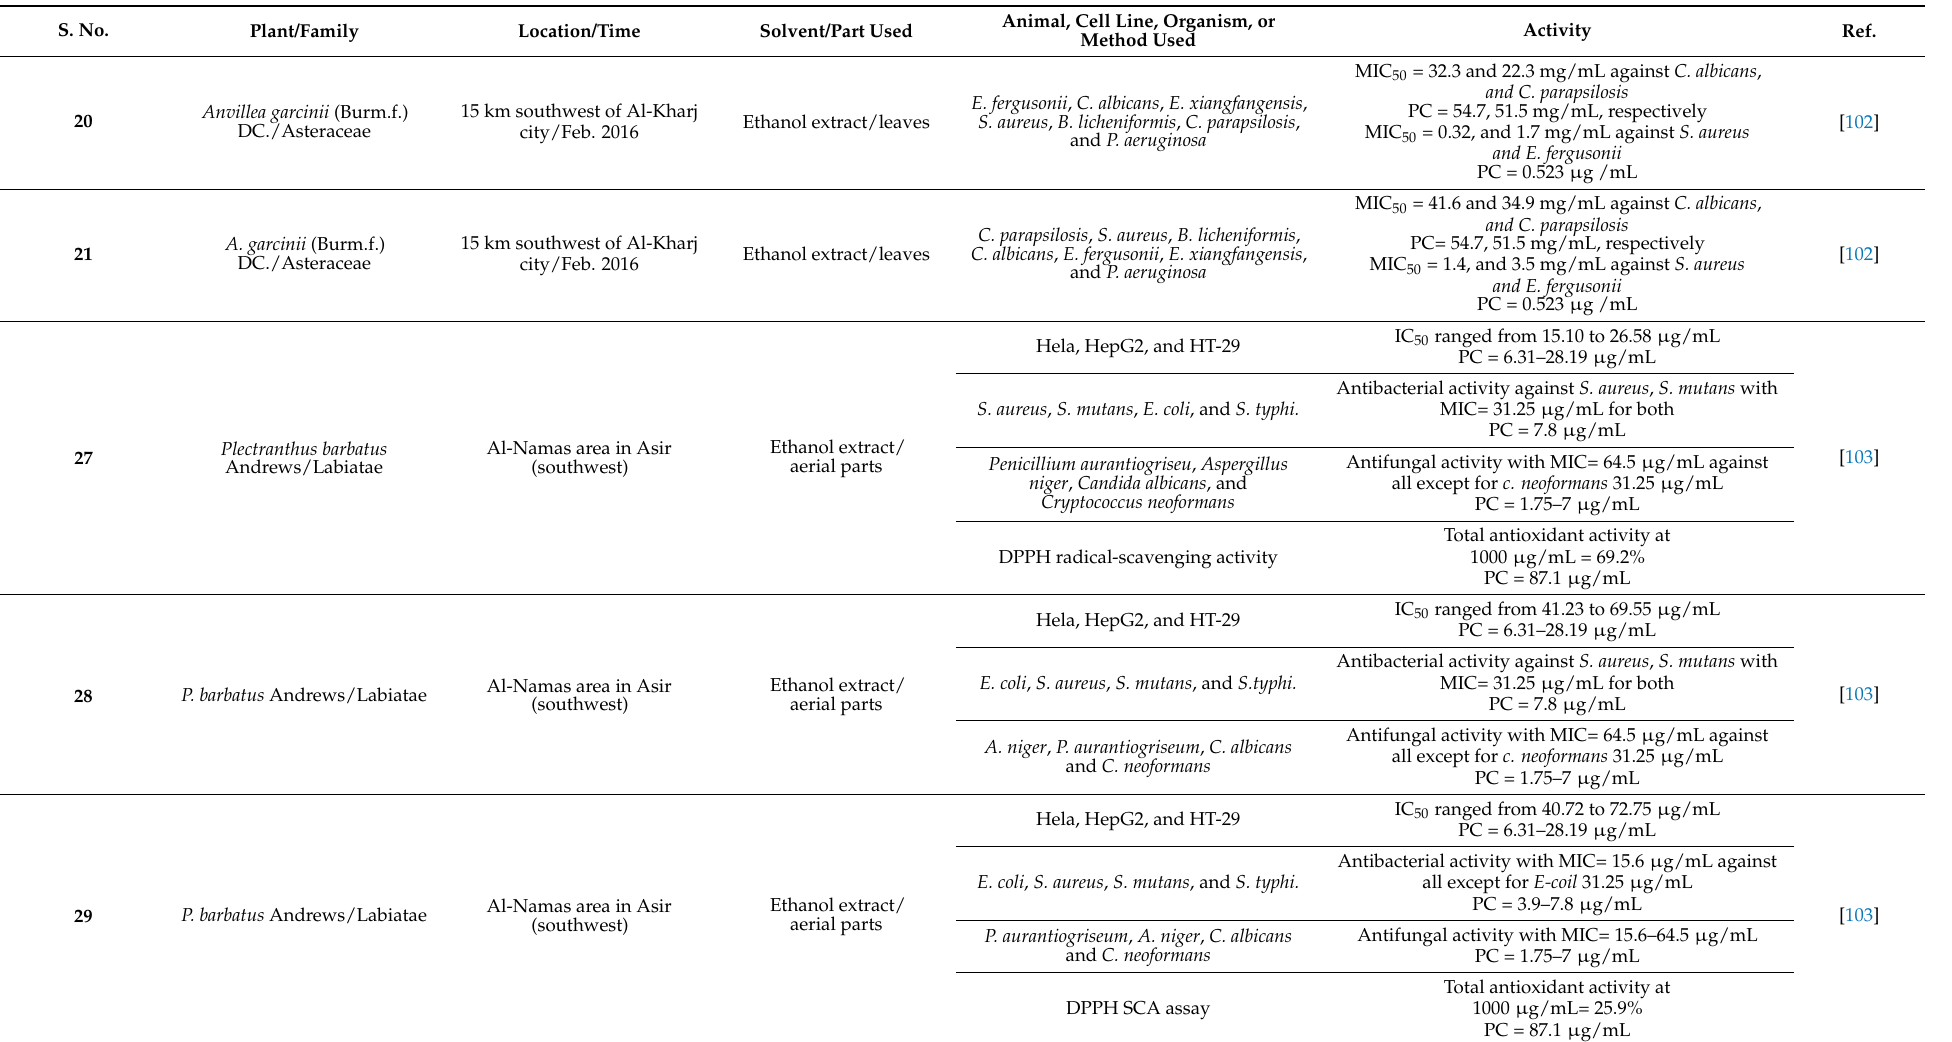
Table 2. The biological activities of isolated compounds of plants grown in the southwestern regions of